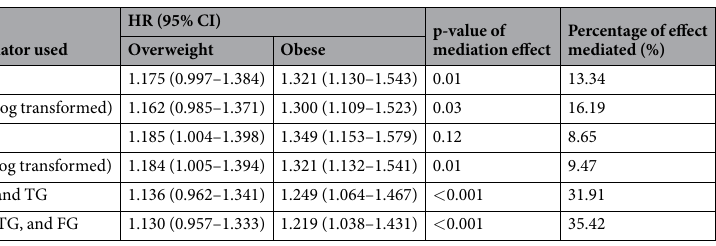
Table 4. HRs and excess risk of overweight and obesity mediated through different combinations of metabolic risk